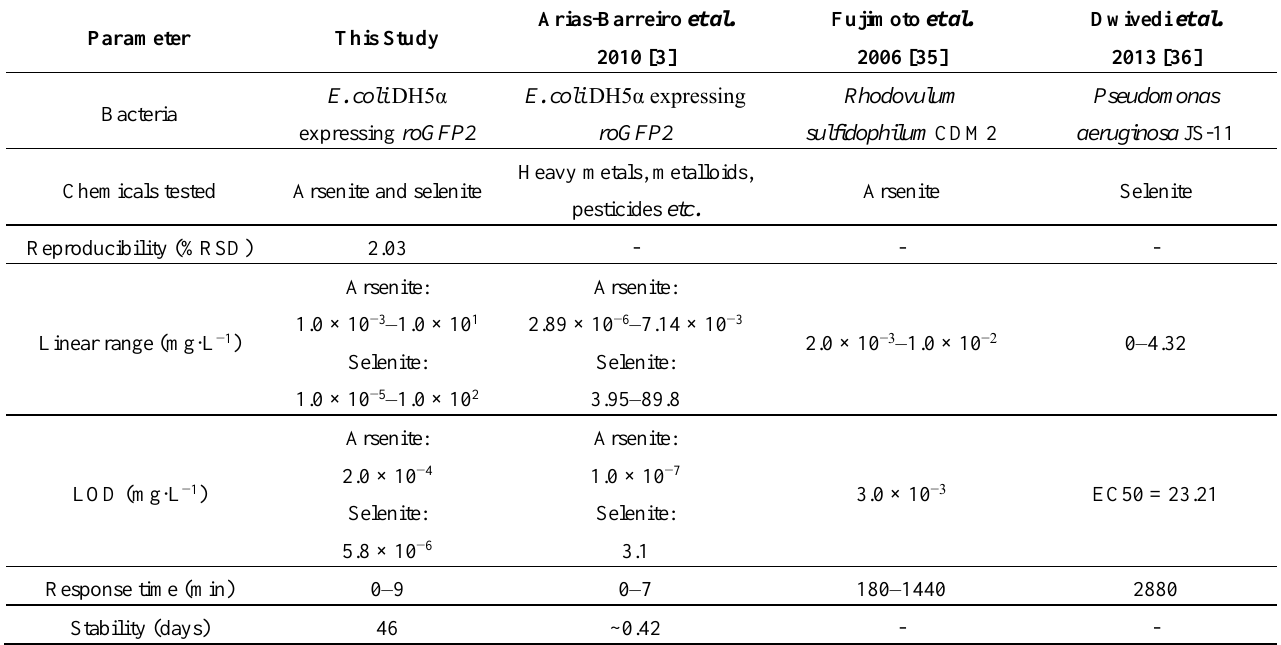
Table 1. Performance comparison of E. coli roGFP2 oxidative stress biosensor with reported whole-cell oxidative stress biosensors using arsenite and/or selenite as the